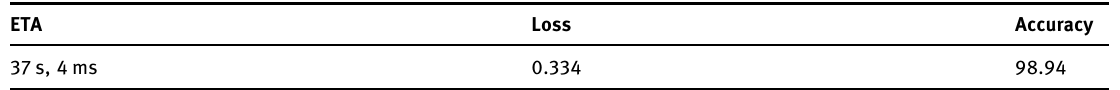
Table 6: Testing in performance